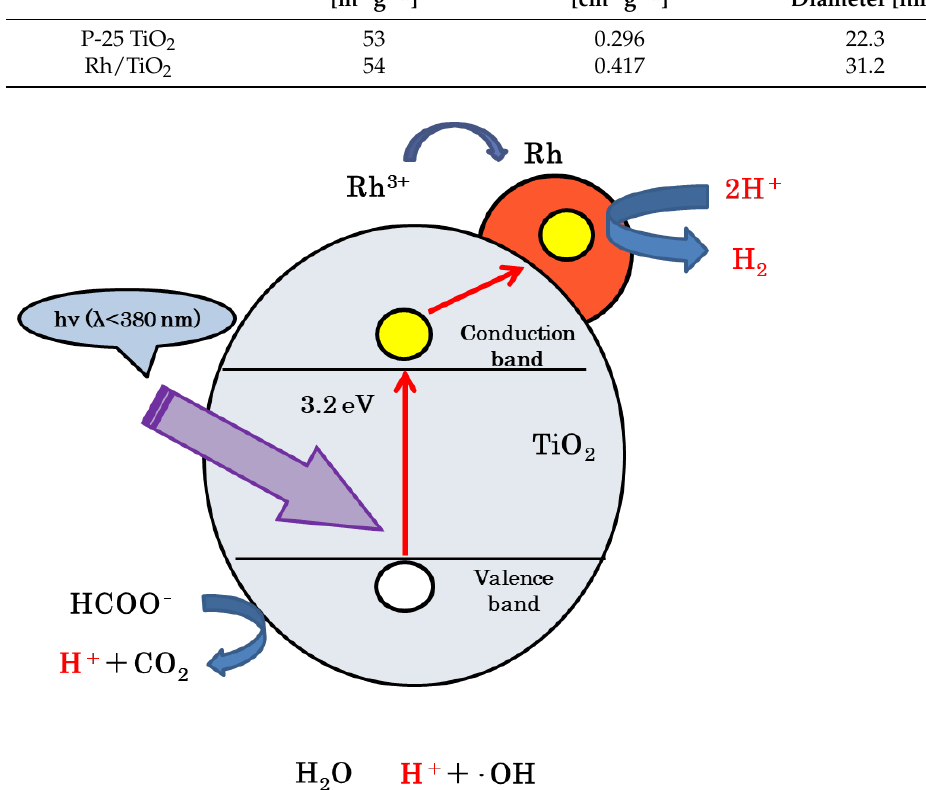
Figure 13. Photocatalytic hydrogen generation from a formic acid solution using the TiO 2 photo- catalyst with the simultaneous photo-deposition of